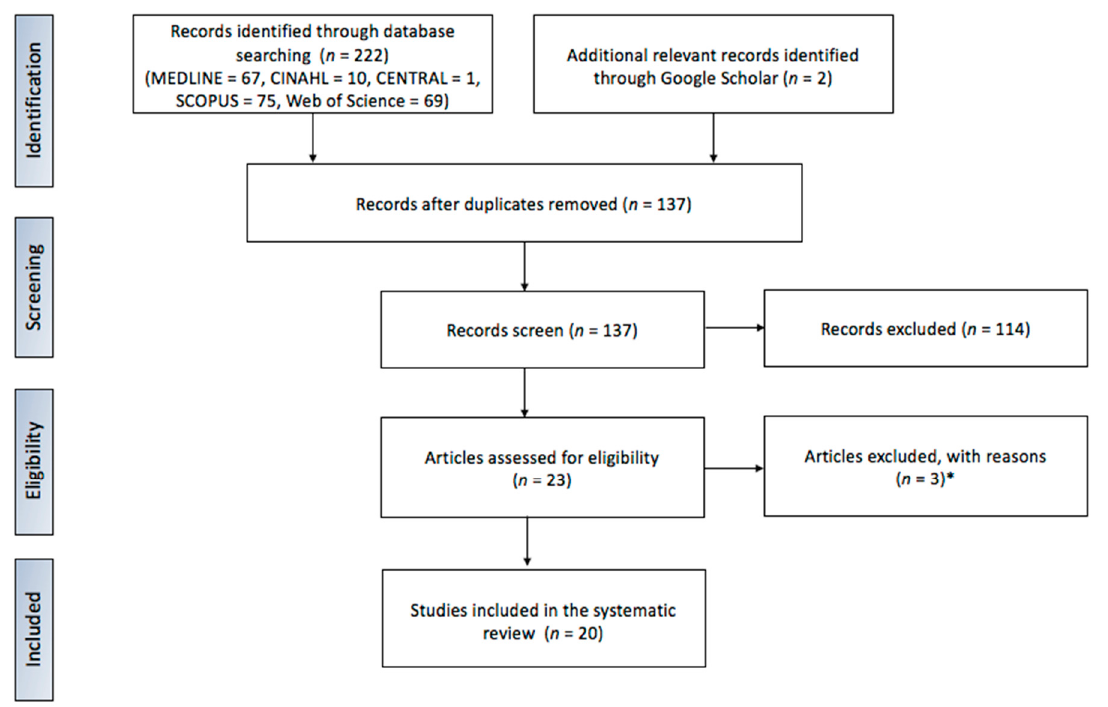
Figure 1. Literature search based on PRISMA protocol. * Articles were excluded due to their purely review nature.